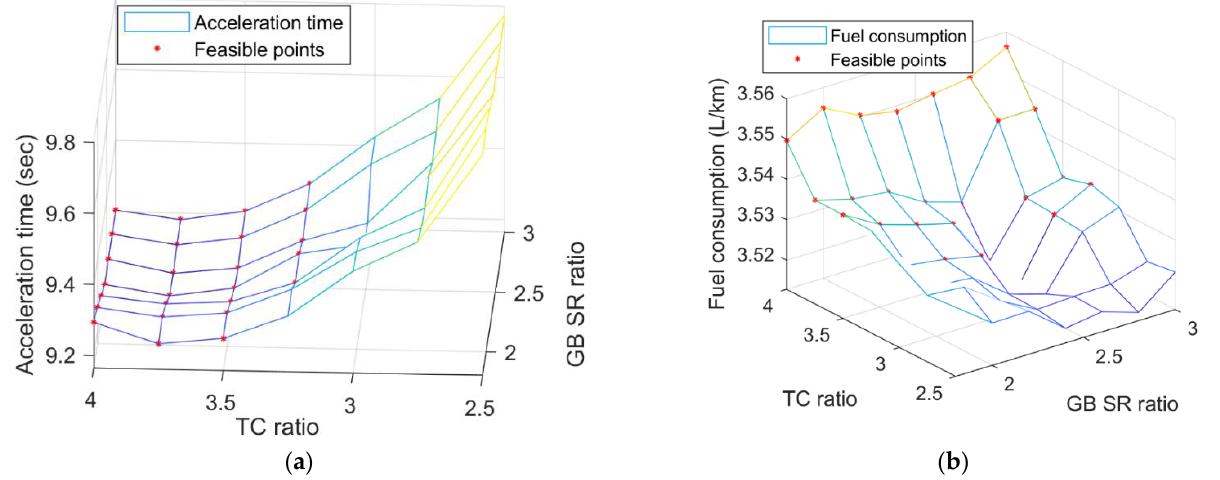
Table 2. Lower and upper ranges of parameters.